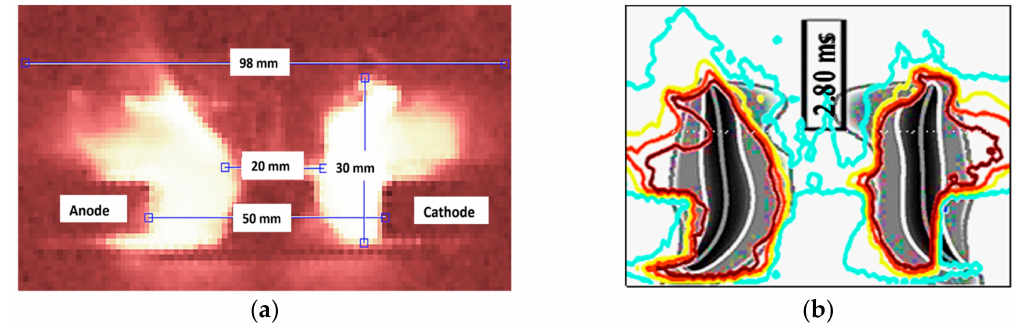
Figure 10. ( a ) Enlarged image of the arc and ( b ) Its light intensity contours extracted by the image processing vs. simulated arc at 2.8 ms.